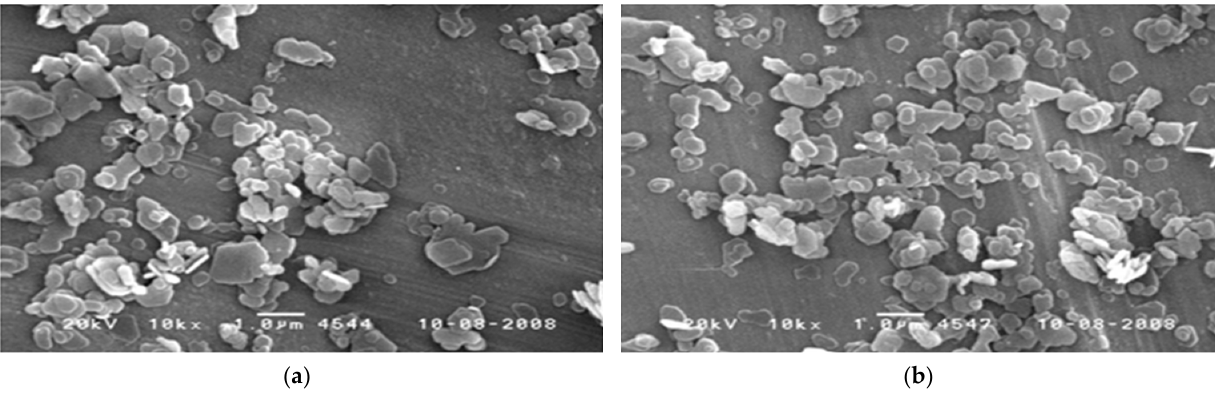
Figure 2. SEM observation results of magnesium hydroxide by surface treatment: ( a ) unmodified Mg(OH) 2 ; ( b ) surface treatment with silane (MSi).